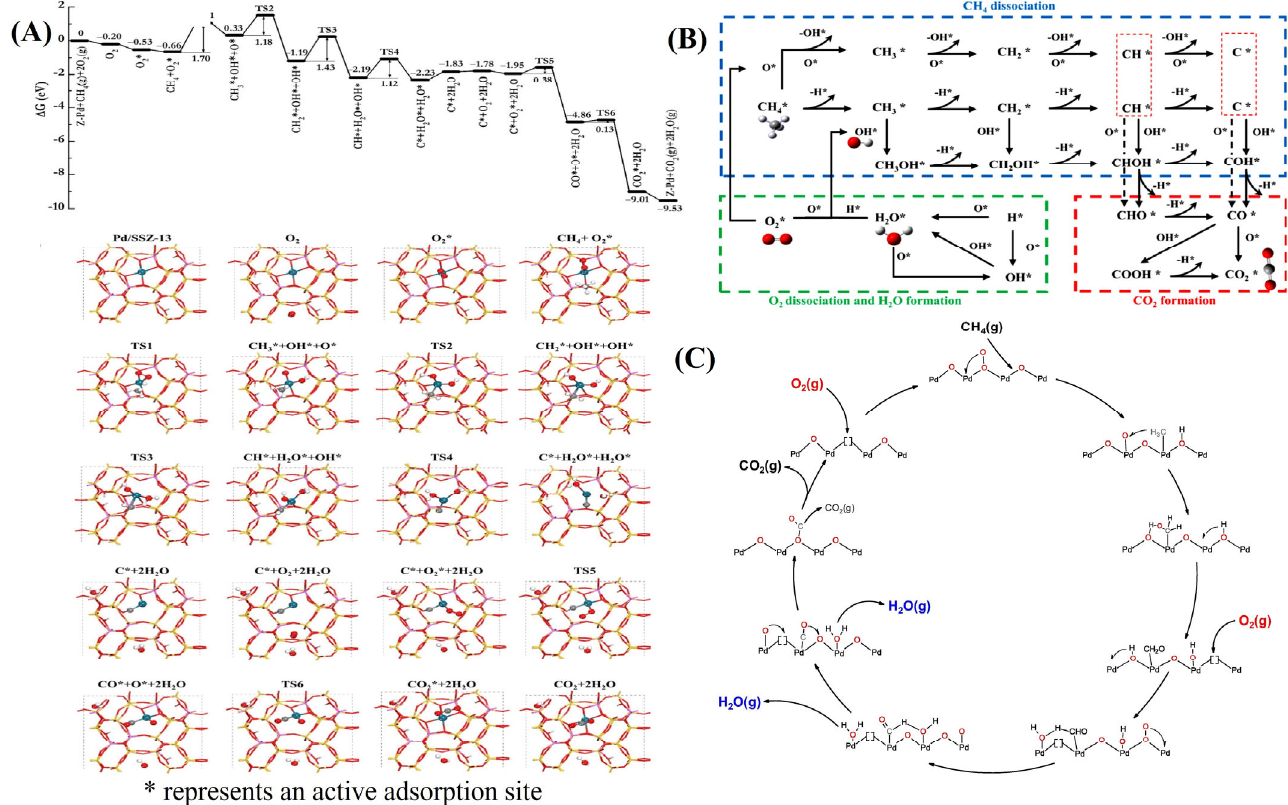
Figure 1. ( A ) Gibbs free energy profile of CH 4 oxidation over the Pd/H-SSZ-13 and the optimized structures of corresponding reaction intermediates and transition states. Reprinted/adapted with permission from Ref. [57]. Copyright 2022, copyright Elsevier Ltd., ( B ) feasible reaction pathways in the catalytic combustion of methane. Reprinted/adapted with permission from Ref. [59]. Copyright 2021, copyright Elsevier Ltd., and ( C ) catalytic cycle of the preferential reaction path following a Mars − van − Krevelen redox mechanism for methane oxidation over PdO (101) under the dry feed conditions (200–400 °C). Reprinted/adapted with permission from Ref. [62]. Copyright 2019, copyright Elsevier Ltd.